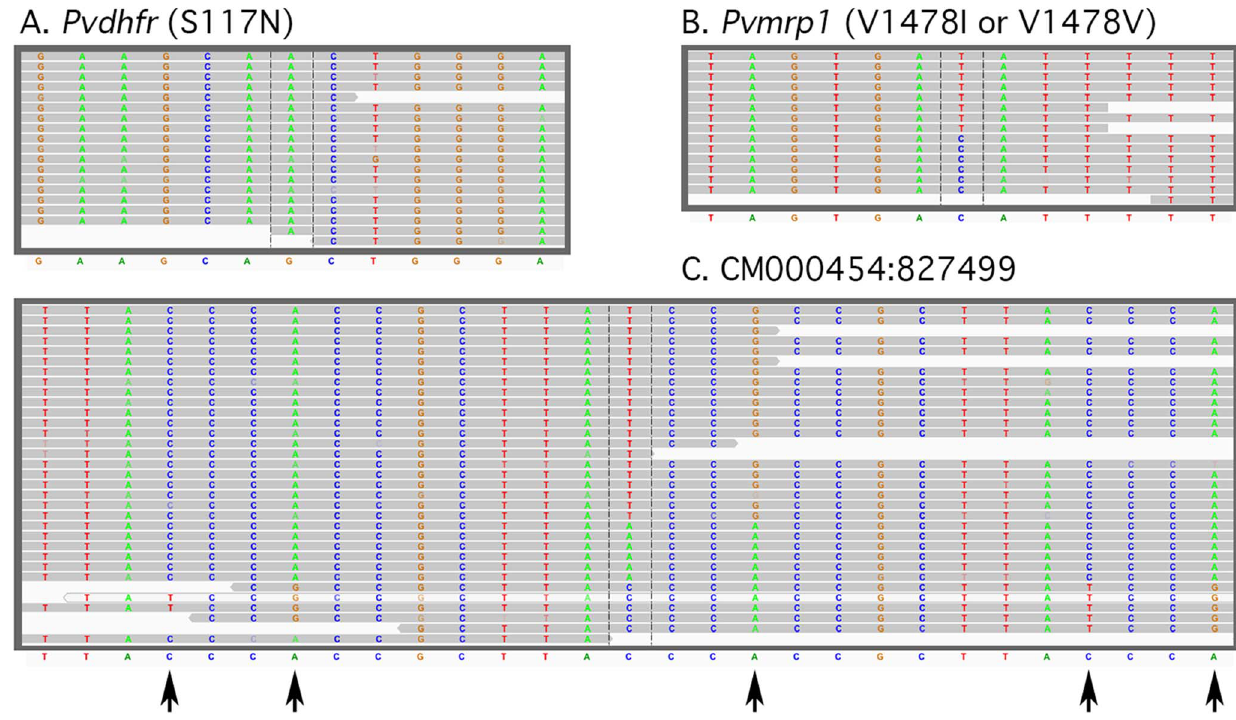
Figure 1. Representative genotype calls. Examples of read alignments from (A) a homozygous SNV (S117N) in P. vivax dihydrofolate reductase (PVX_089950), (B) a heterozygous SNV in the P. vivax multidrug resistance protein 1 (PVX_097025) and (C) a rare multiallelic SNV on chromosome 13 that is suggestive of an alignment error based on multiple mismatches (indicated by arrows) in the fragments carrying the G at the central position. All reads are from EAC01. The Sal I reference allele is shown below.